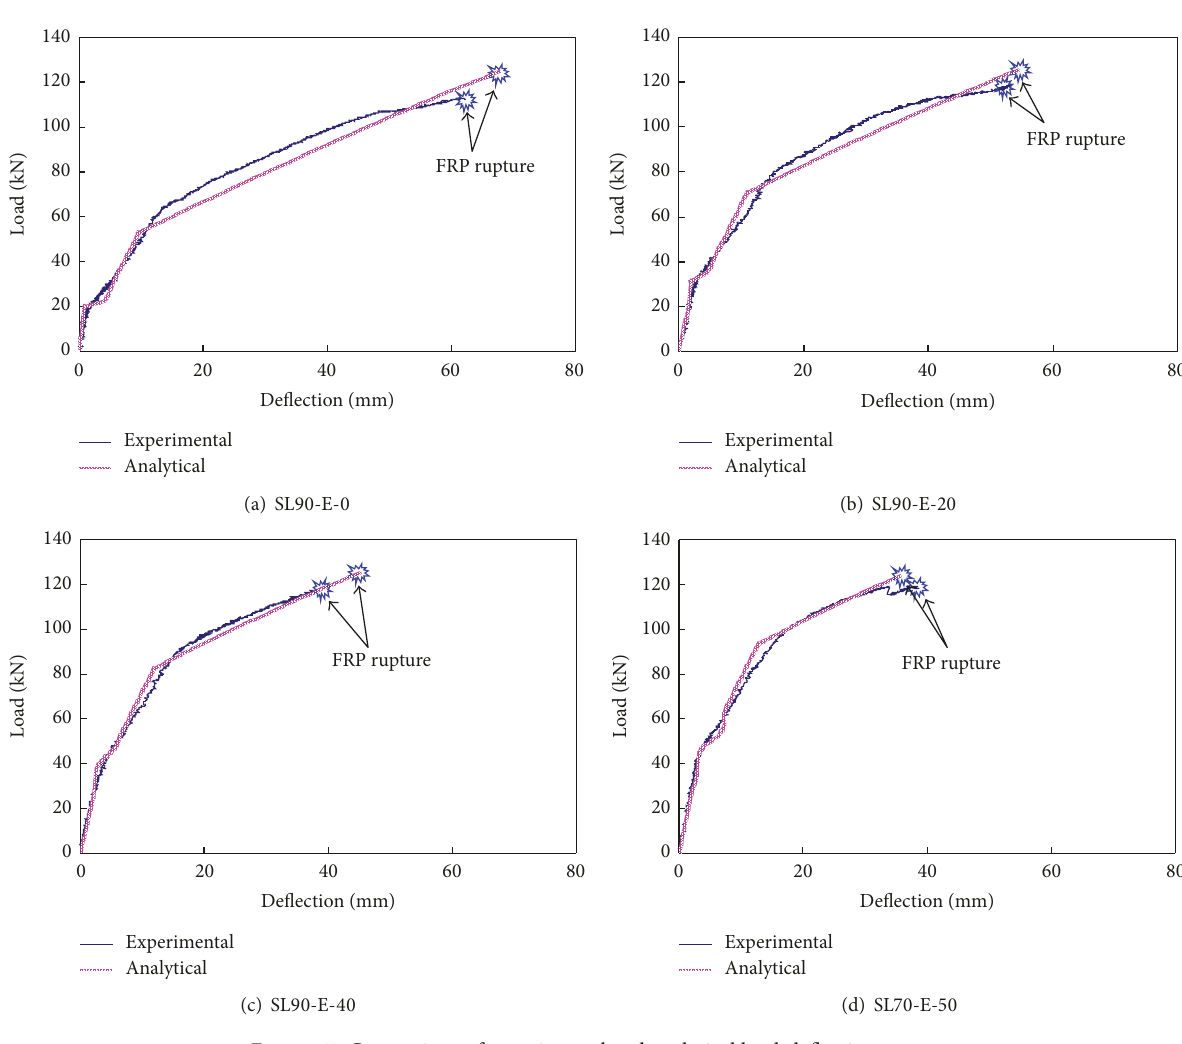
Figure 11: Comparison of experimental and analytical load-deflection